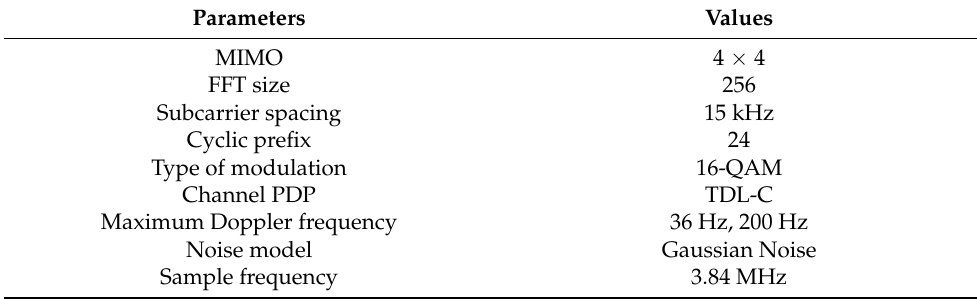
Table 1. The parameter setup for the considered MIMO-OFDM system.